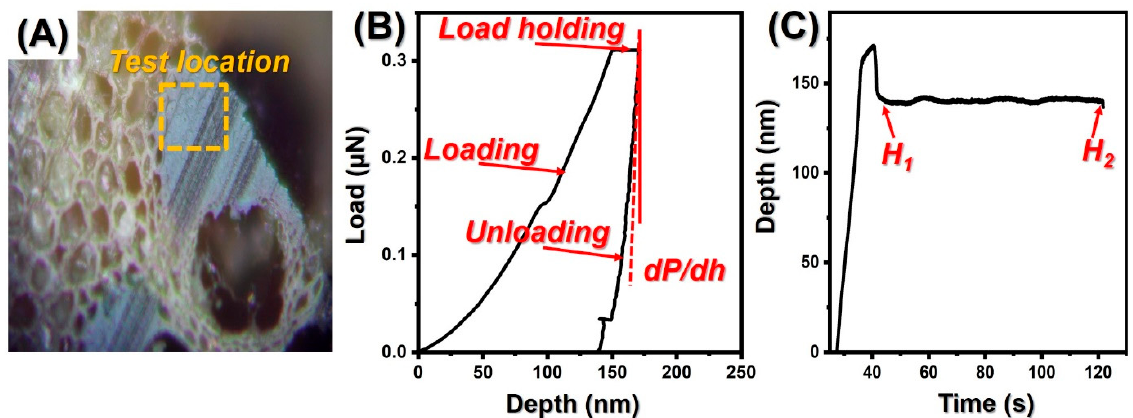
Figure 1. ( A ) image of bamboo cell and test location; ( B ) Typical NI representative load-depth curve of the bamboo cell wall; ( C ) Typical NI depth-time curve of bamboo cell wall.